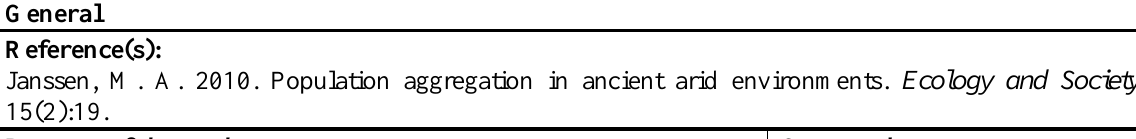
Table A1.4 Standardized protocol for the ABM described by Janssen